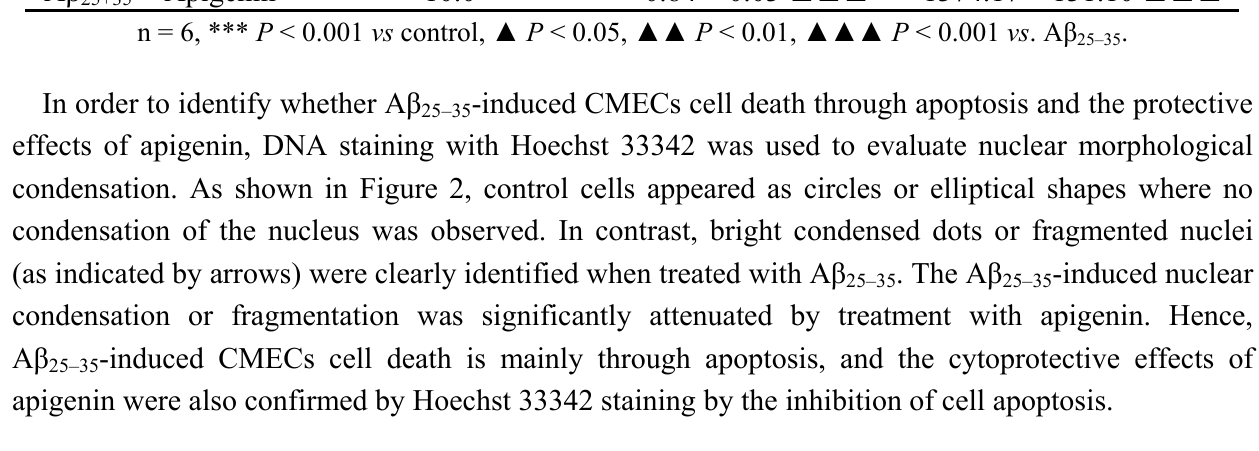
Table 1. Effects of apigenin on cytotoxicity in CMECs against A β